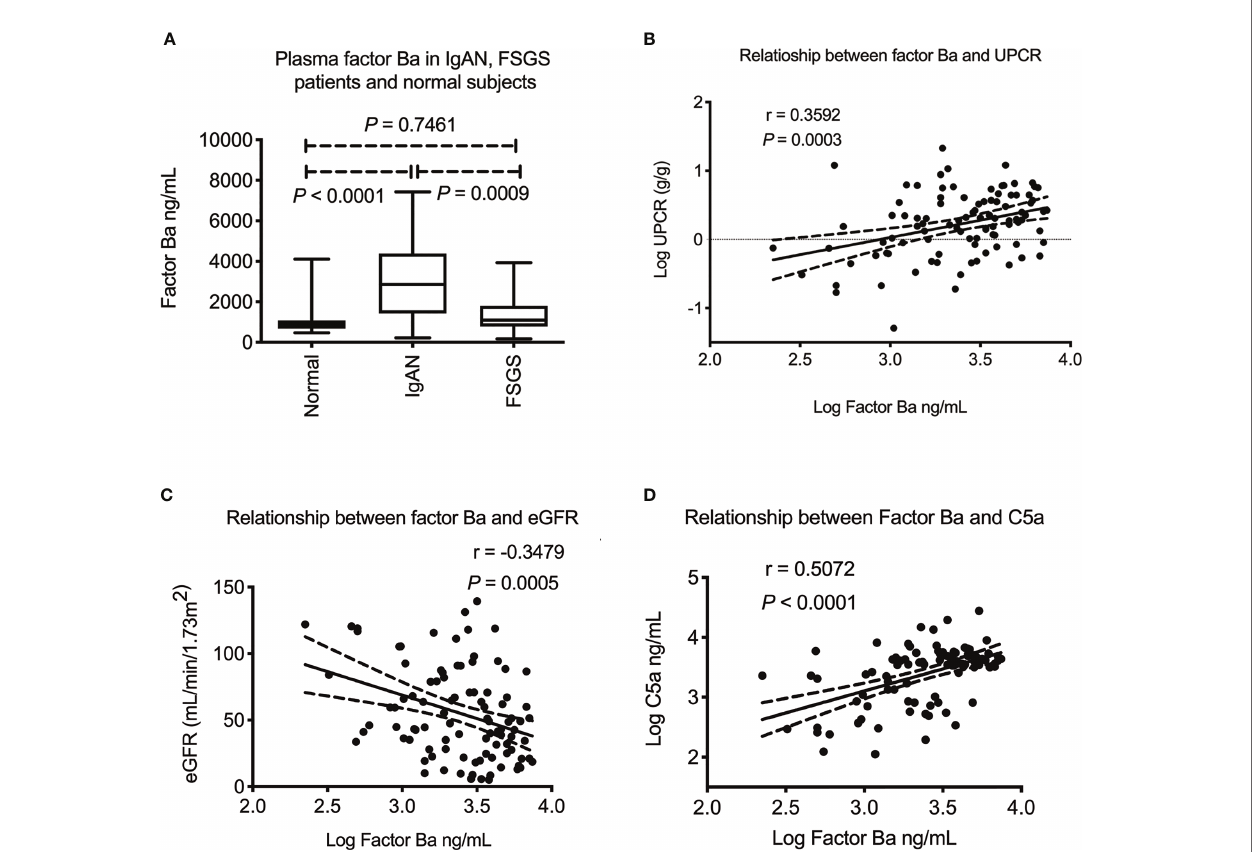
FIGURE 2 | Plasma factor Ba in IgA nephropathy patients. (A) Plasma factor Ba concentration was signi fi cantly higher in IgAN patients than FSGS patients or healthy subjects ( P = 0.0009 and P < 0.0001) There was no difference of plasma factor Ba between FSGS patients and normal subjects. ( P = 0.7461). (B) Plasma factor Ba level signi fi cantly correlated with level of proteinuria in IgAN patients ( P = 0.0003, r = 0.36). (C) Plasma factor Ba level negatively correlated with renal function ( P = 0.0005, r = -0.35). (D) There was positive association between level of plasma factor Ba and C5a ( P < 0.0001, r = 0.51). UPCR, urinary protein to creatinine ratio; eGFR, estimated glomerular fi ltration rate; FSGS, focal segmental